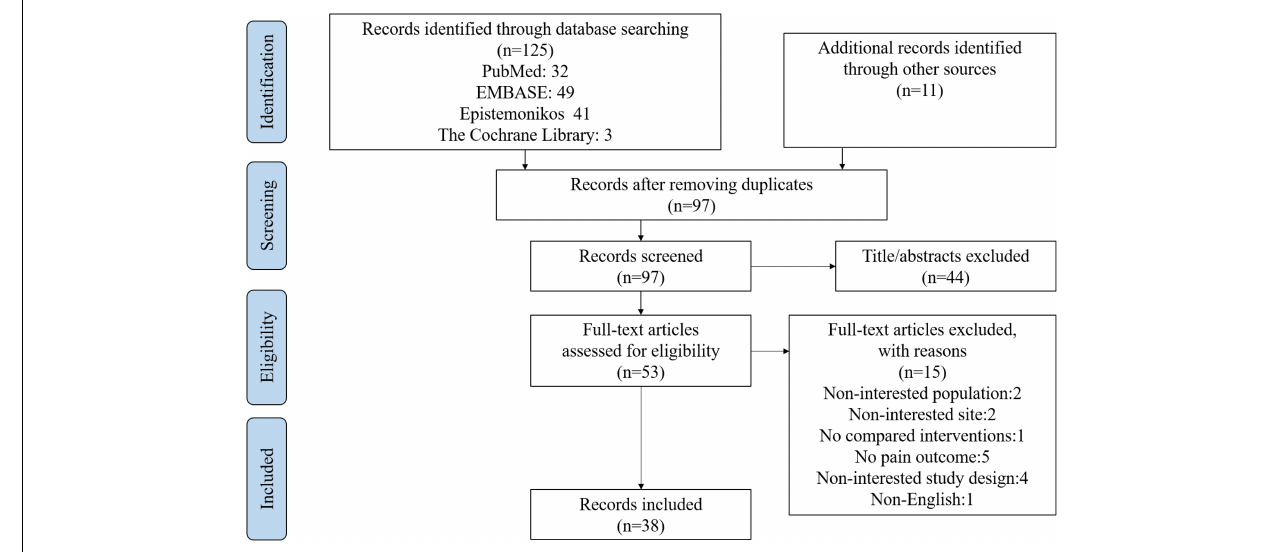
FIGURE 2 | PRISMA flow diagram detailing the selection process.